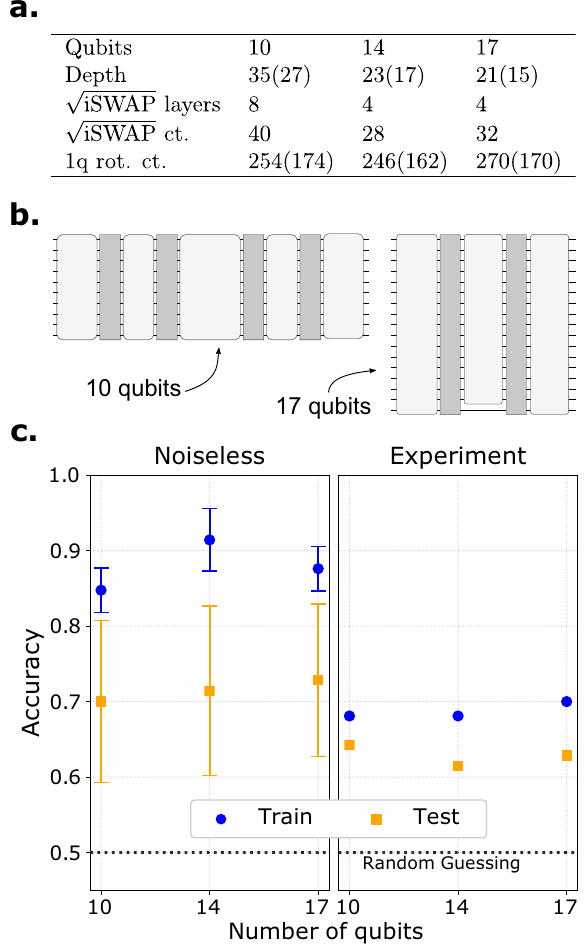
Fig. 4 Experimental implementation and noiseless vs. experi- mental results. a Parameters for the three circuits implemented in this experiment. Values in parentheses are calculated ignoring contributions due to virtual Z gates. b The depth of the each circuit and number of entangling layers (dark gray) scales to accommodate all 67 features of the input data. c The test accuracy for hardware QKM is competitive with the noiseless simulations even in the case of relatively low circuit fi delity, across multiple choices of qubit counts (the simulated test accuracies for n = 10, 14 were statistically indistinguishable from optimized RBF performance, similarly to Fig. 3 for n = 17). The presence of hardware noise signi fi cantly reduces the ability of the model to over fi t the data. Error bars on simulated data represent standard deviation of accuracy for an ensemble of SVM classi fi ers trained on 10 size- m downsampled kernel matrices and tested on size- v downsampled test sets (no replacement). Dataset sampling errors are propagated to the hardware outcomes but lack of larger hardware training/test sets prevents characterization of general- ization error (e.g. using bootstrapping techniques 40